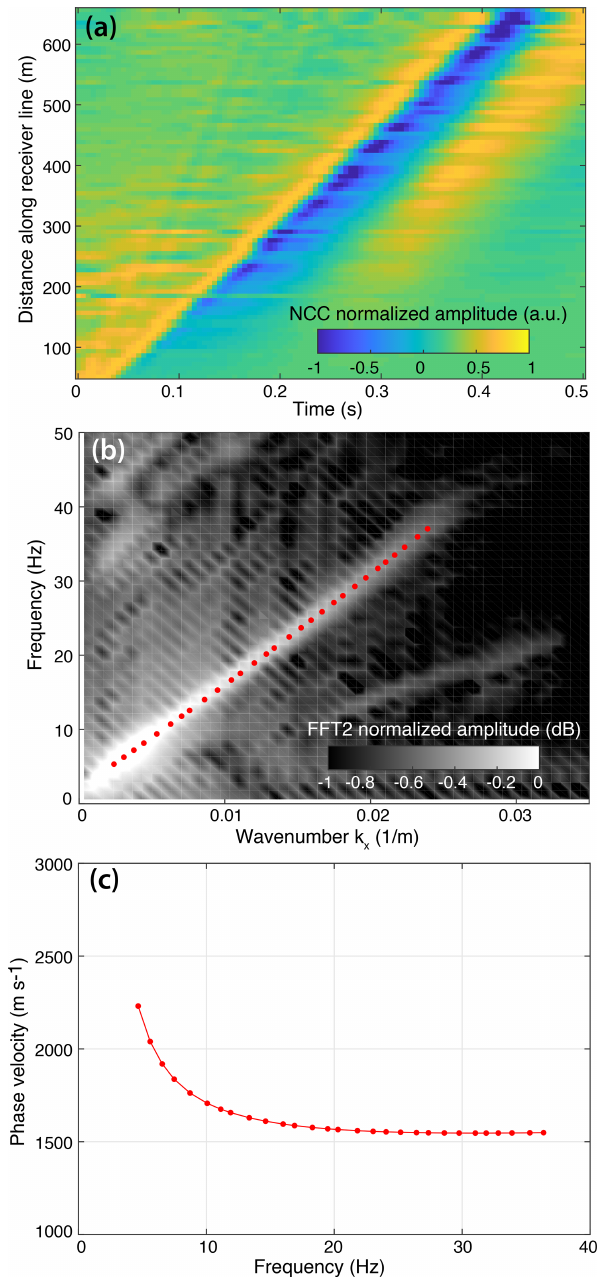
Figure B1. Computation of Rayleigh wave phase velocity from f-k analysis of the noise cross-correlation section obtained at the Argen- tière array (a) . (b) Frequency–wavenumber diagram obtained from the 2-D Fourier transform of (a) . Red dots show the peaks of en- ergy maximum at each frequency and correspond to the Rayleigh wave fundamental mode. (c) Phase velocity dispersion curve ob- tained from the interpolated peaks in (b)